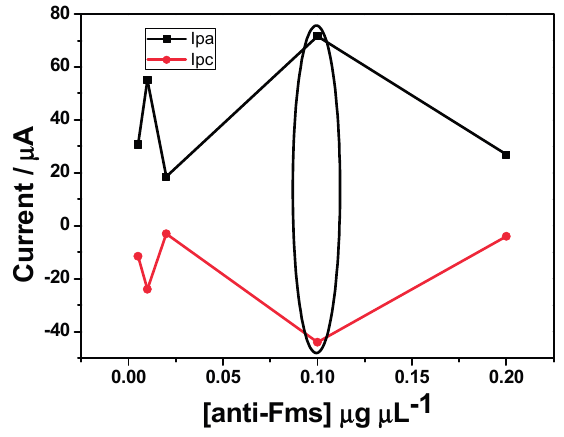
Figure 2. Effect of fumonisin antibody concentration in PBS.